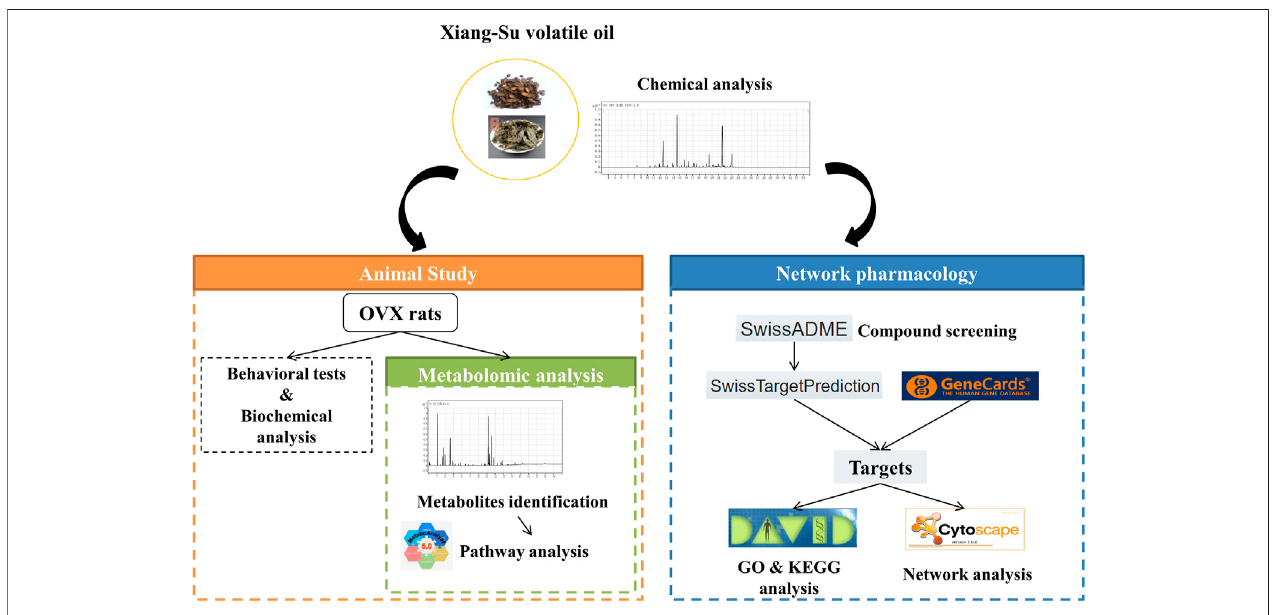
FIGURE 1 | Schematic diagram of the